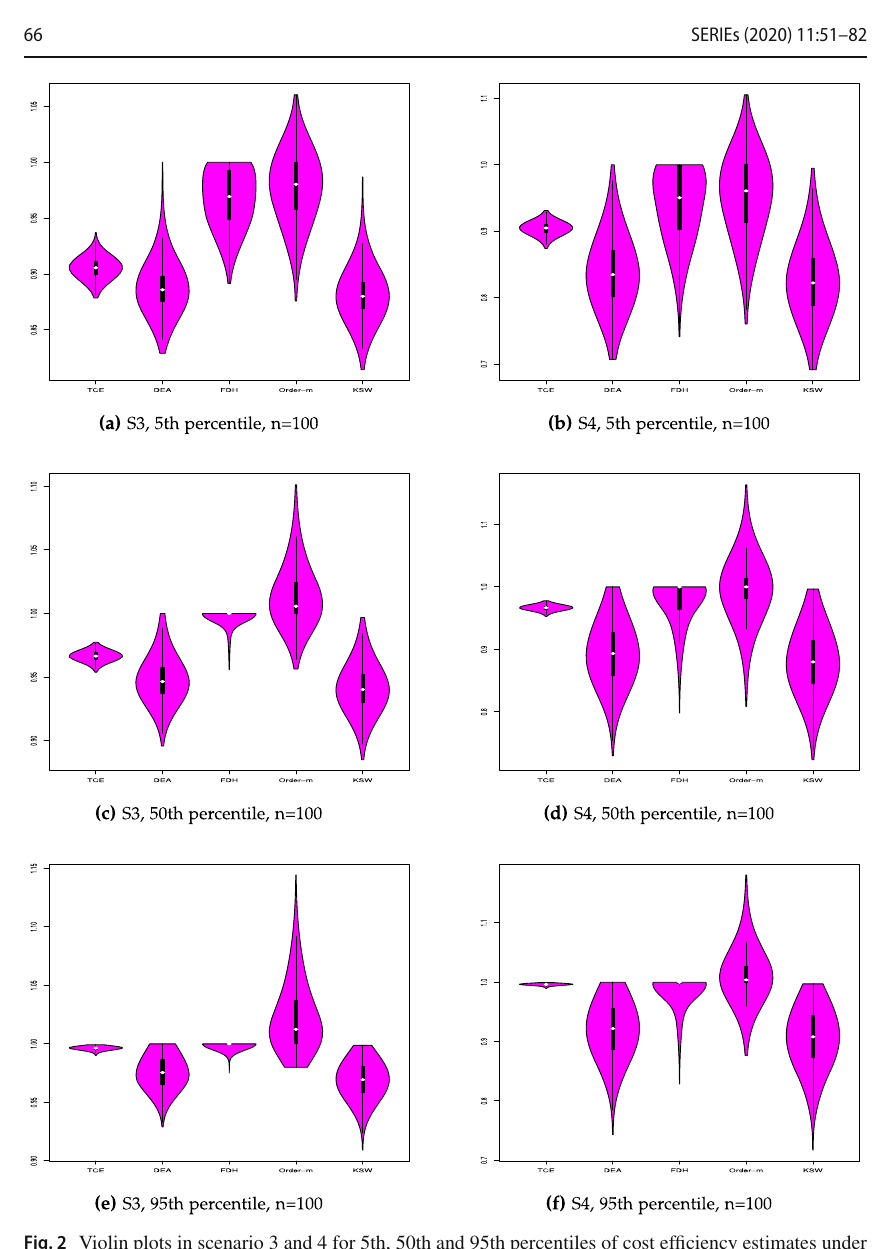
Fig. 2 Violin plots in scenario 3 and 4 for 5th, 50th and 95th percentiles of cost efficiency estimates under a Cobb-Douglas cost